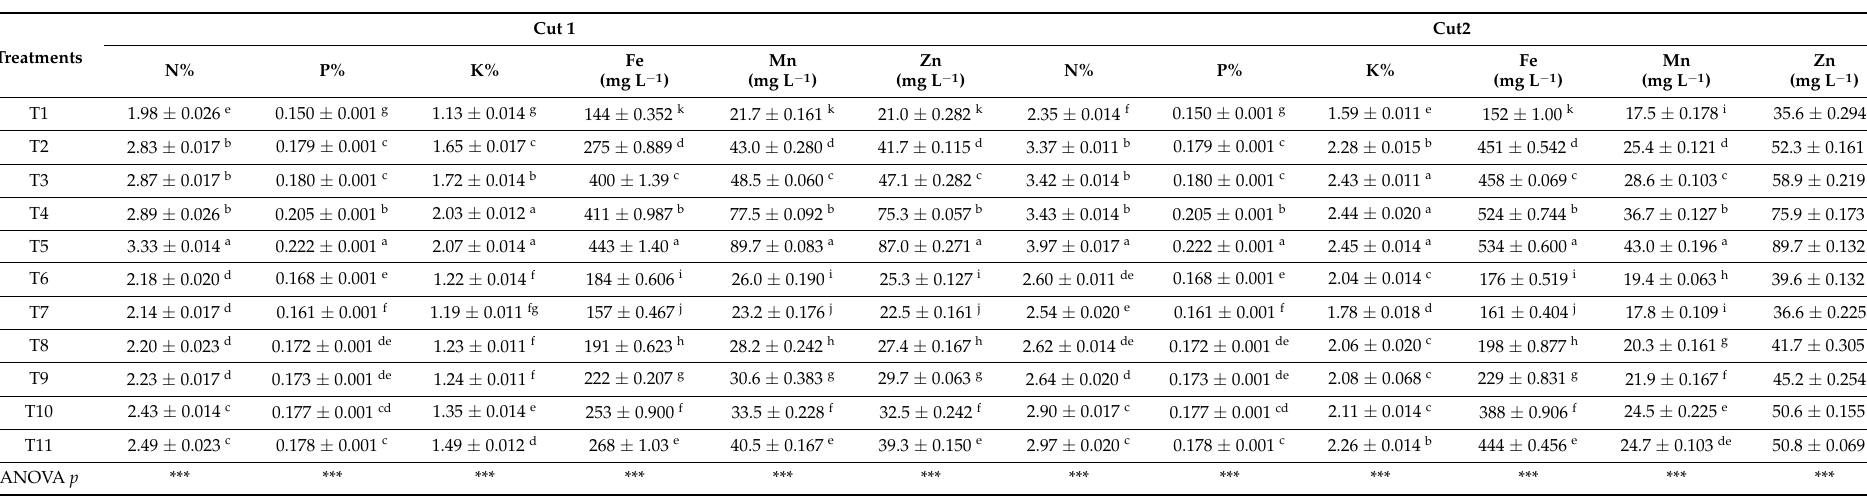
Table 7. Effect of iron (nano, sulfate, and chelated) foliar spray on nutrients content of Sweet Scented Geranium in the first and second cut during the 2019 experimental season. Means of three replicates are presented with ±